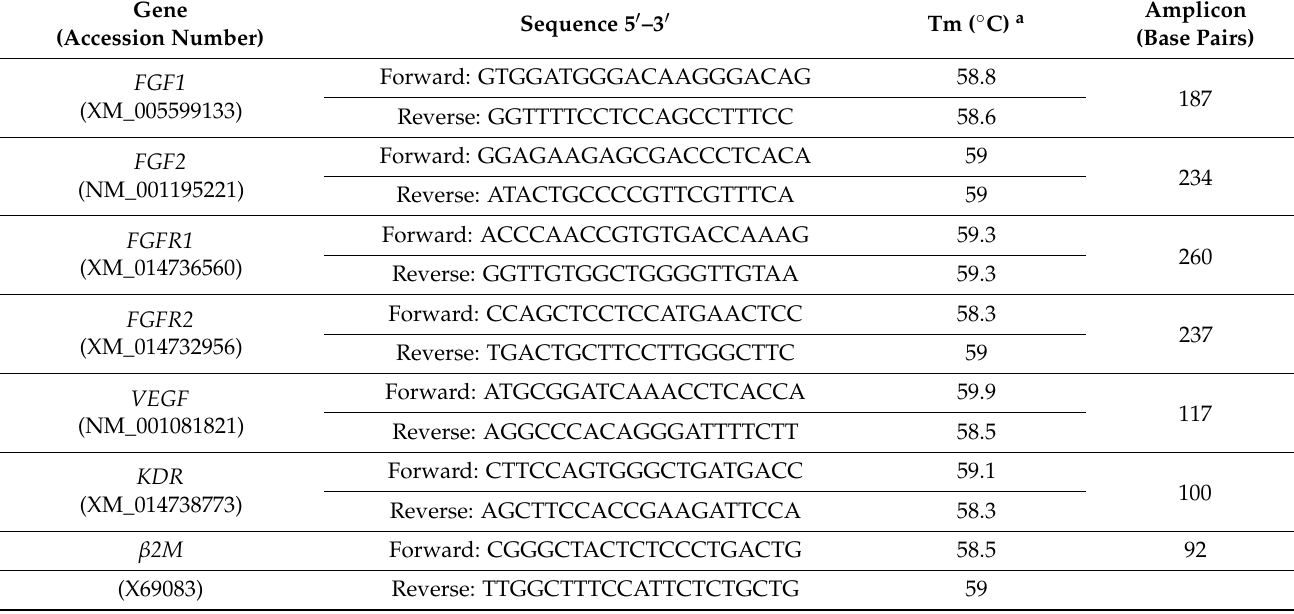
Table 1. Primer sequences used for gene transcription analysis by real-time